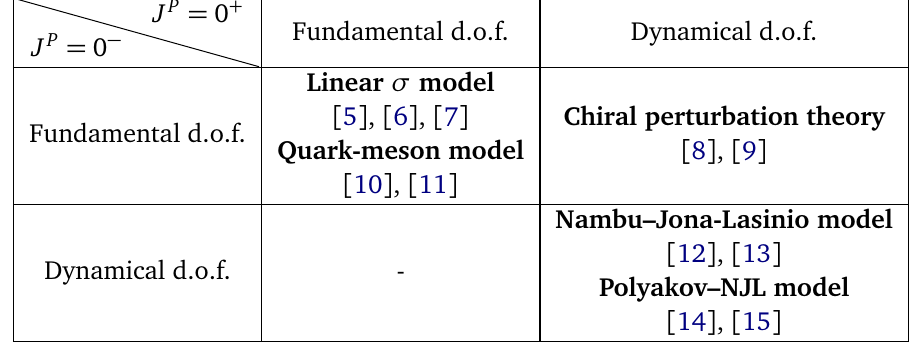
Table 1: Different models / effective theories where the chiral partners π ( J P = 0 − ) and σ ( J P = 0 + ) can be both fundamental degrees of freedom, dynamically generated states, or a hybrid scenario with one fundamental and one emergent